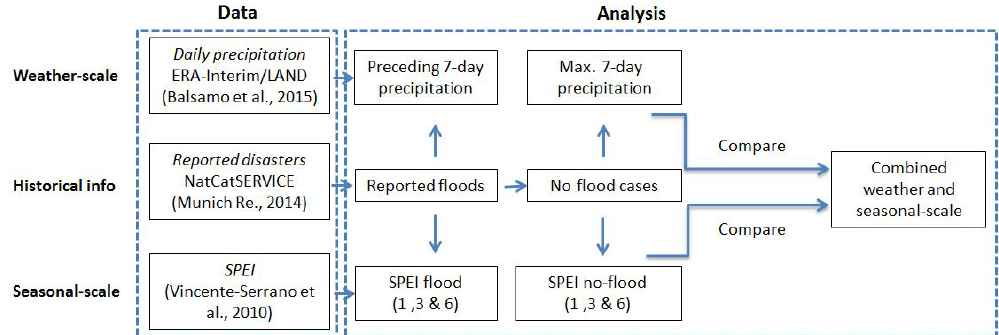
Figure 1. Schematic overview of the approach followed in this